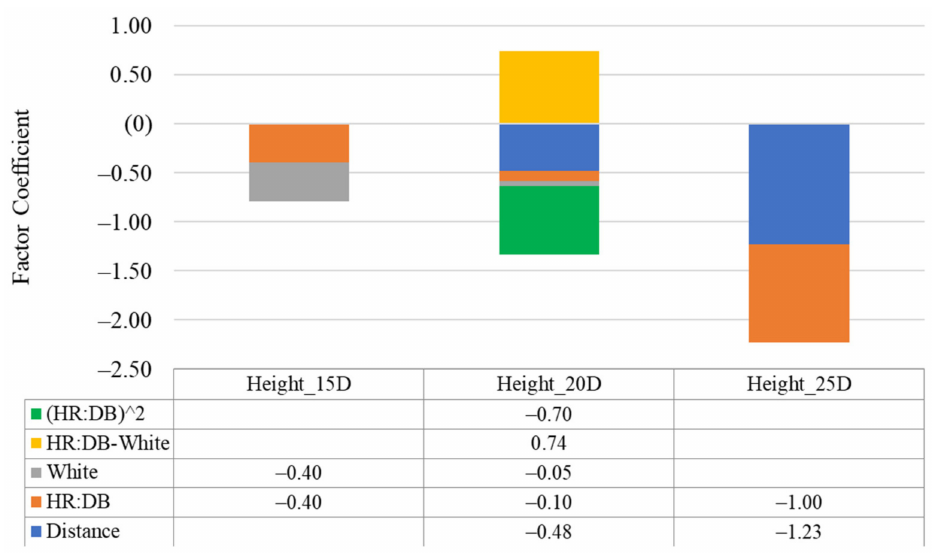
Figure 3. Coefficients of the significant factors for statistically reliable models associated to Height. The associated error is equal to